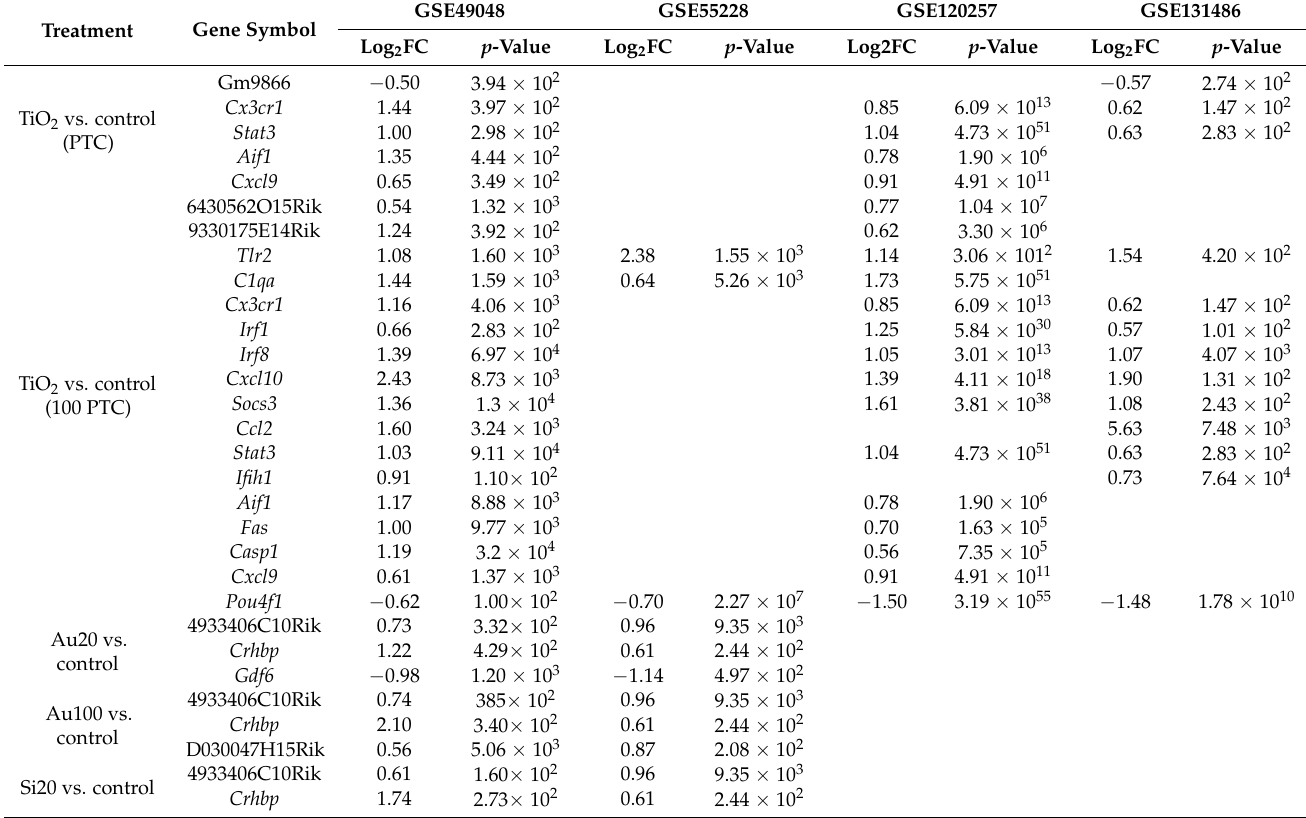
Table 1. Crucial genes changed by nanoparticles to induce the retinal